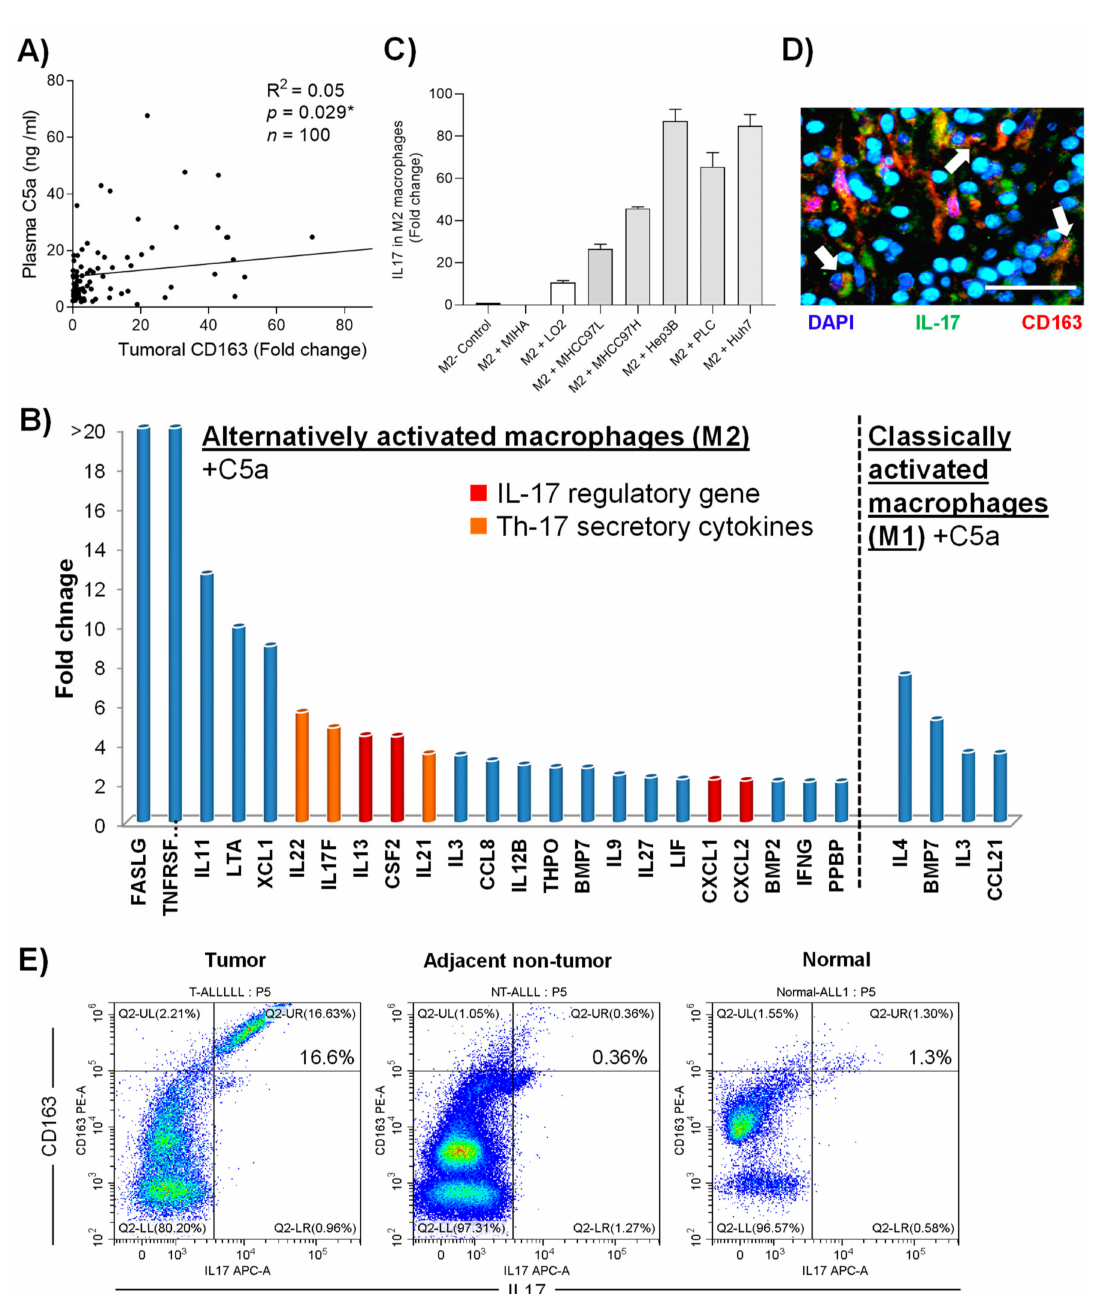
Figure 5. The protumor functions of C5a via M2 macrophages activation. ( A ) Correlation between plasma C5a and scavenger receptor (SA) expression level in the tumoral tissues. ( B ) cDNA expression array analysis of M1 and M2 macrophages treated with recombinant C5a compared to untreated group. ( C ) Expression of IL-17 in M2 macrophages after incubation of HCC-conditioned medium. ( D ) Double immunofluorescence image of a clinical tumoral section labeled with antibodies against IL-17 (green) and CD163 (red). ( E ) Expression of surface CD163 and intra-cellular IL-17 in total CD45+ population of tumoral, adjacent non-tumoral tissue and healthy liver tissue isolated from HCC patients measured by flow cytometry. Scale bar: 100 µ m. Error bar indicated SEM. (Chi-square test for Figure 5A)(Unpaired t -test for Figure